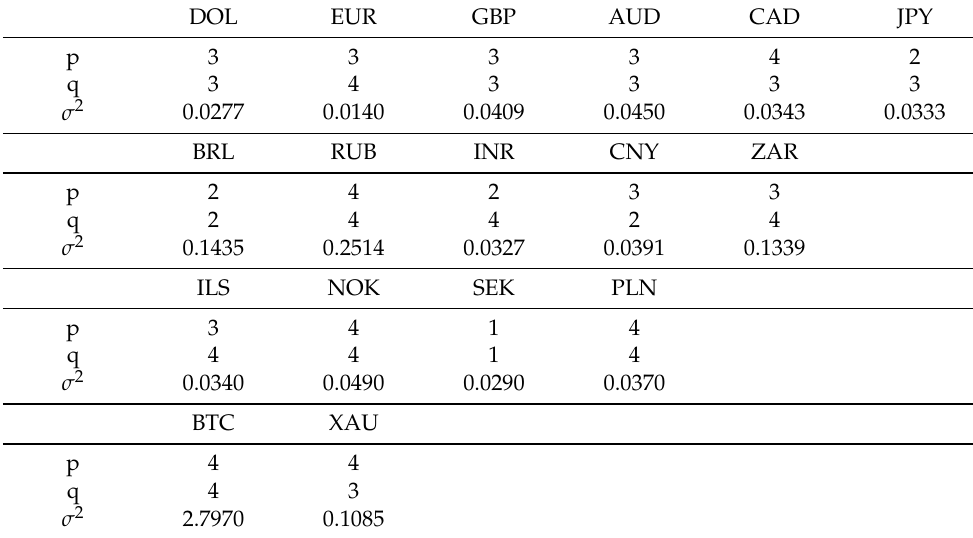
Table 1. Best-fit ARMA processes for each currency. DOL EUR